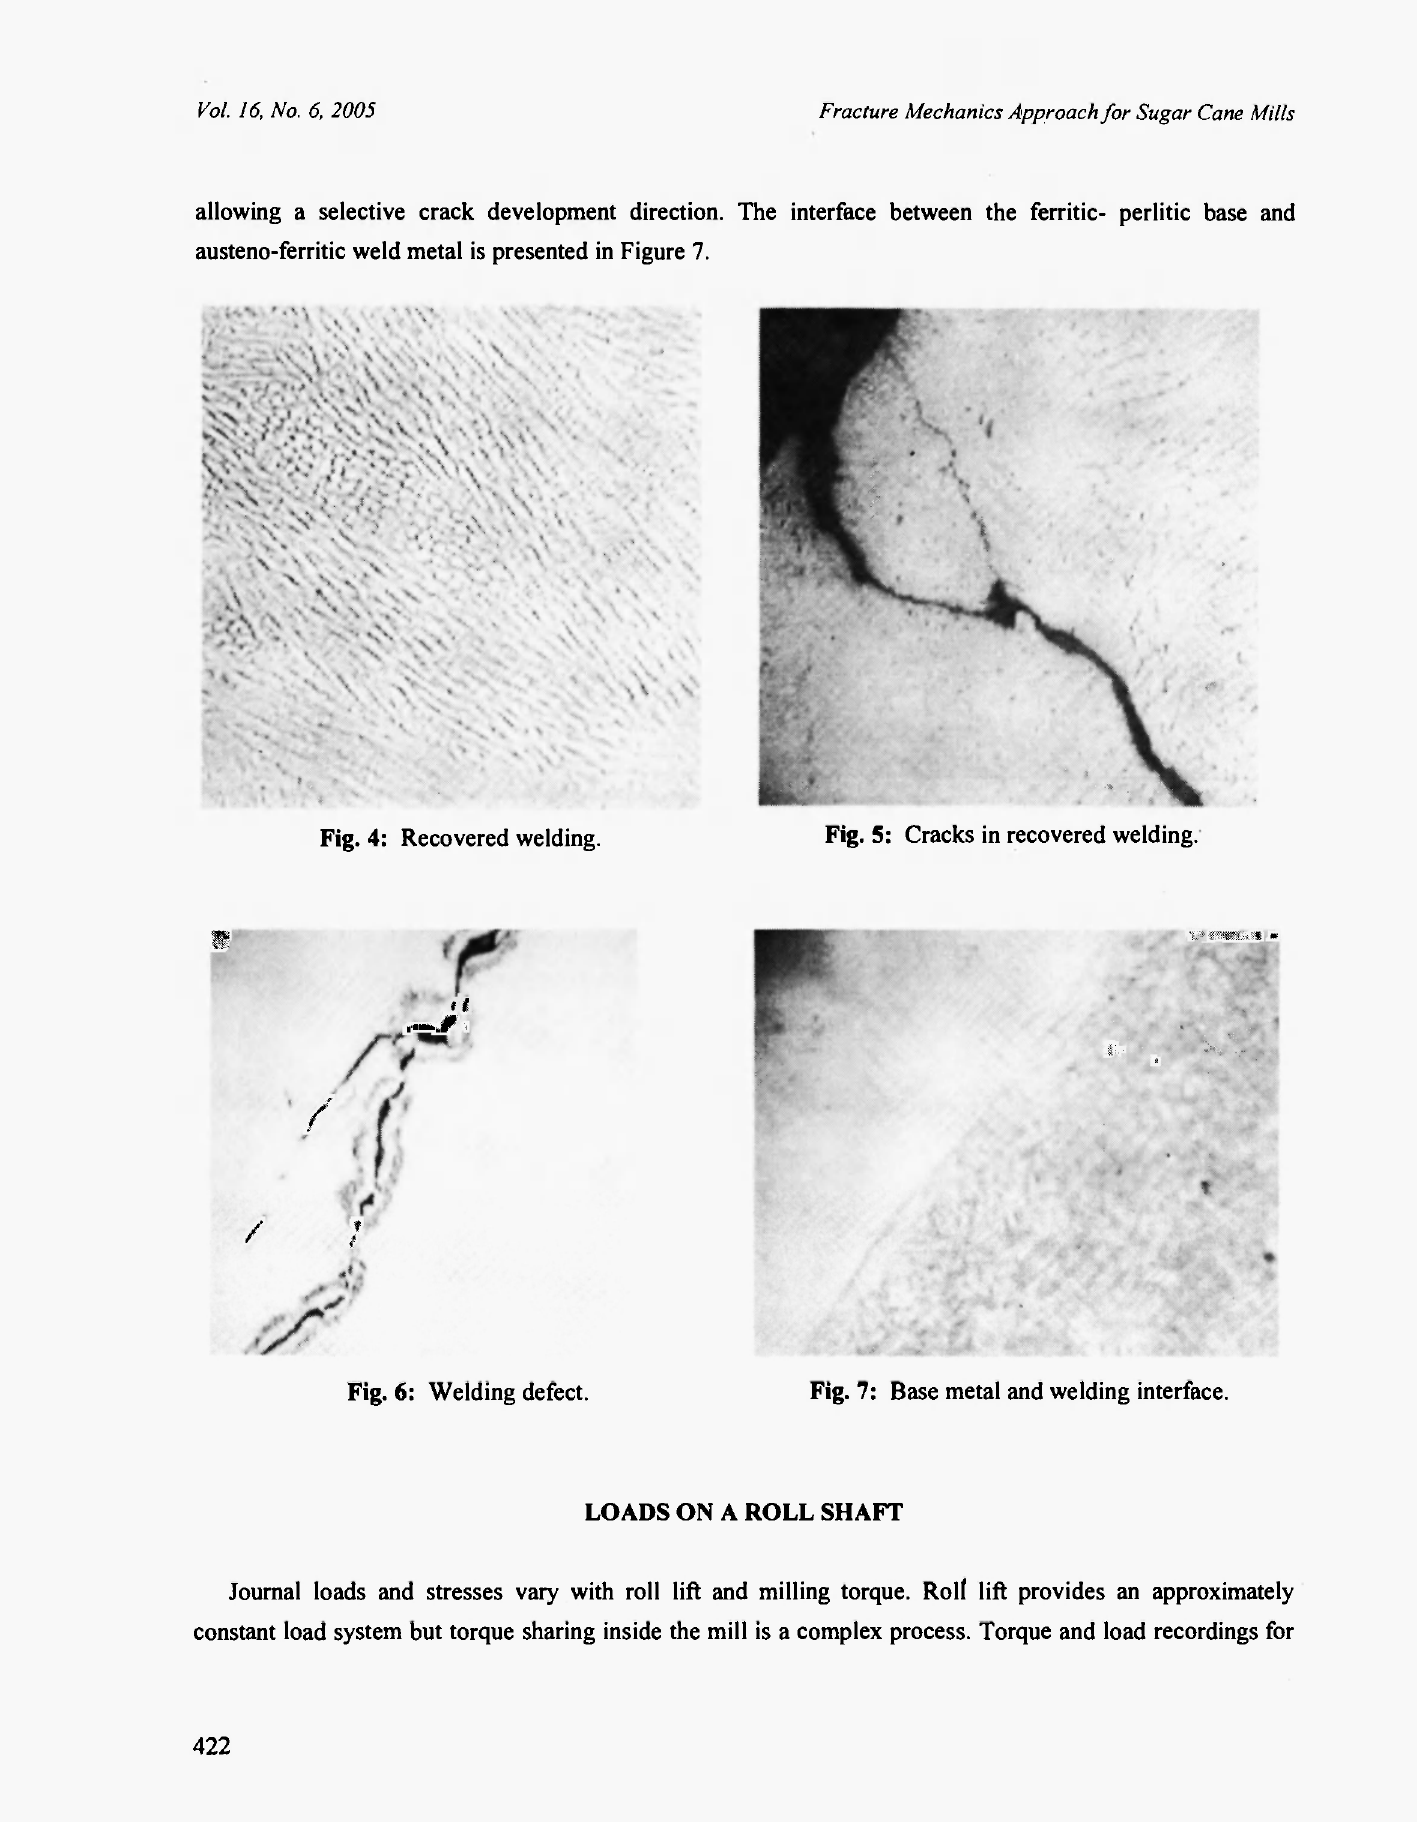
Fig. 6: Welding defect. Fig. 7: Base metal and welding